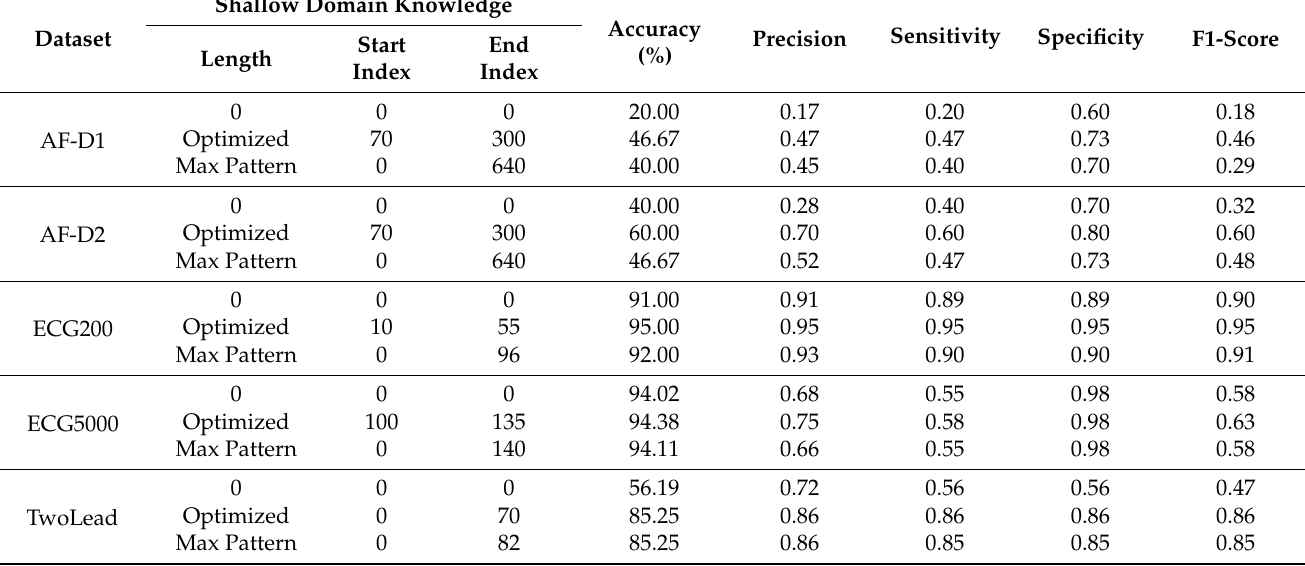
Table 8. Performance evaluation of SDK-Injection among various lengths of shallow domain